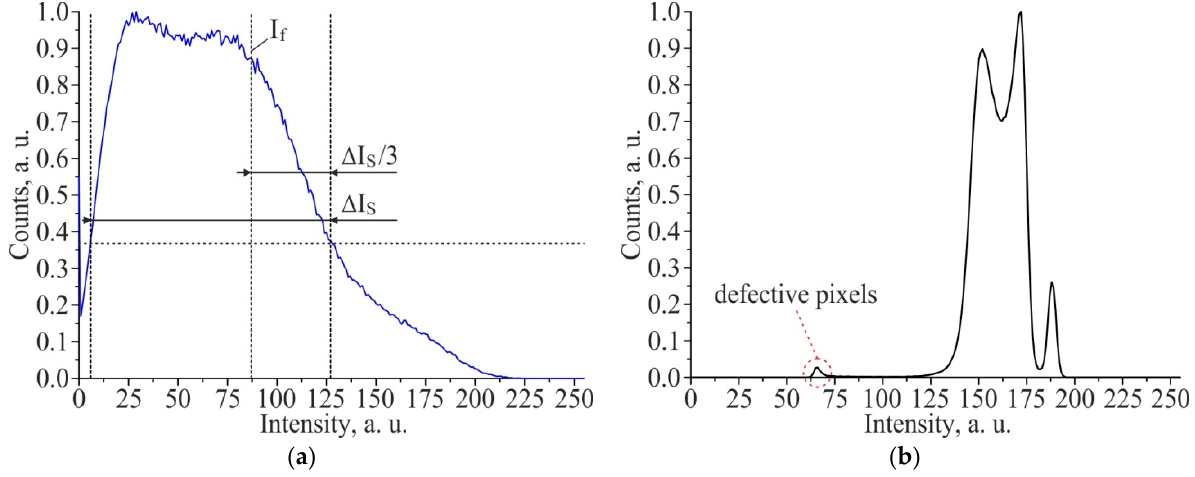
Figure A1. Analysis of the graph of the distribution of pixel intensity on the SEM image of TLIPSS: highlighting the light and dark areas of the investigated periodic structure ( a ); an example of the selection of defective pixels by analyzing the intensity distribution graph ( b ).